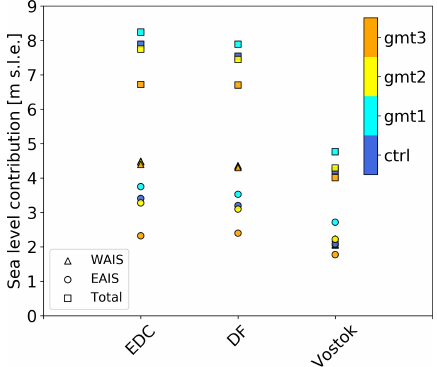
Figure 11. Sea level contribution (in ms.l.e.) of each SGSEN mem- ber during the global sea level highstand (405ka for EDC and DF, 410ka for